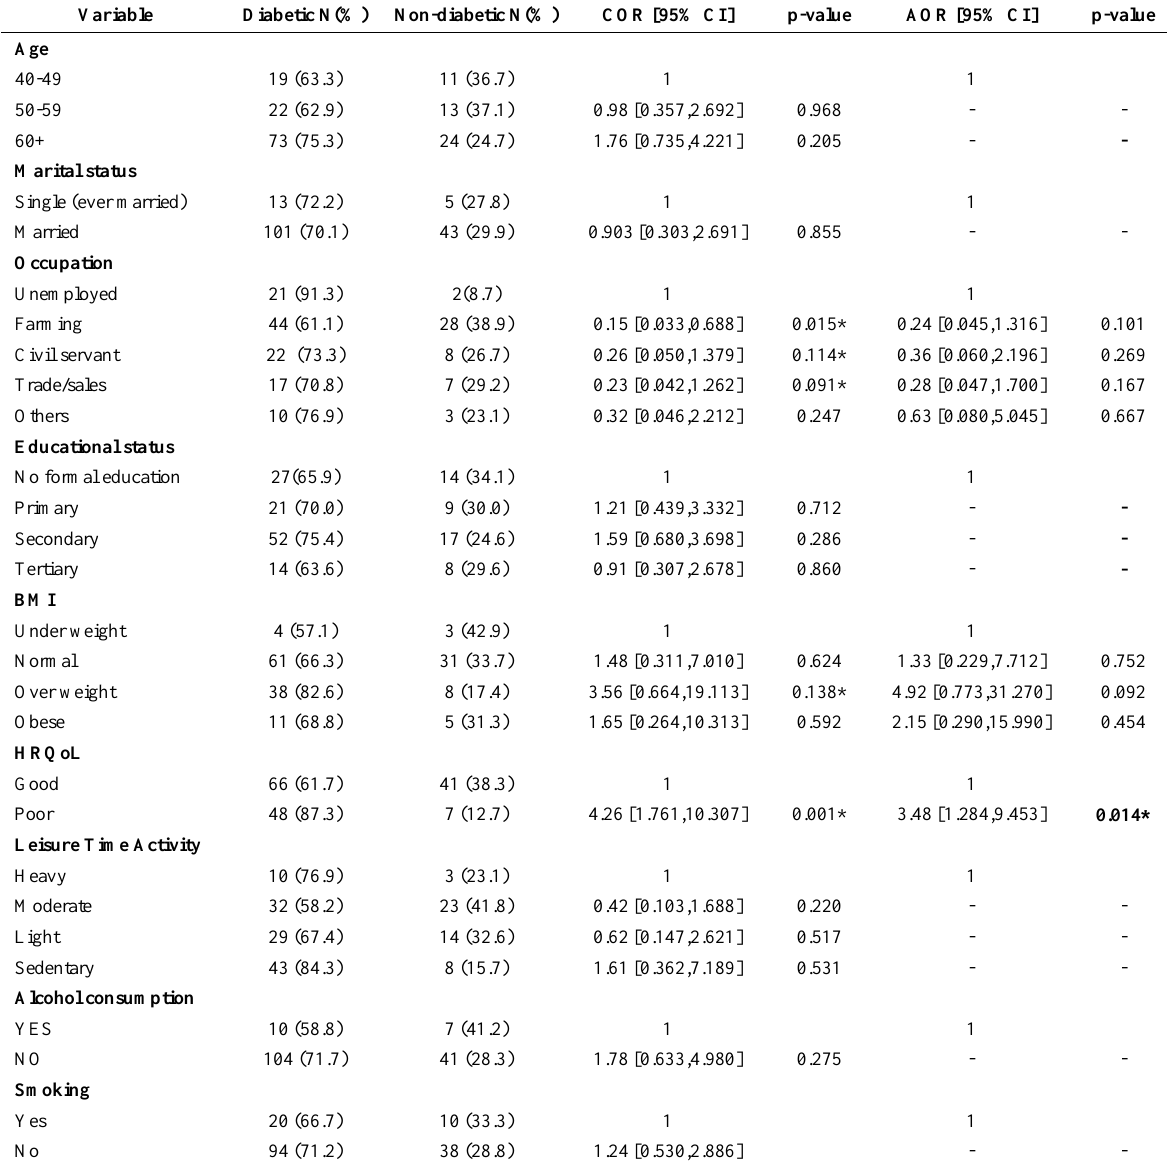
Table 3. Binary and multivariable logistic regression about determinants of ED among the study